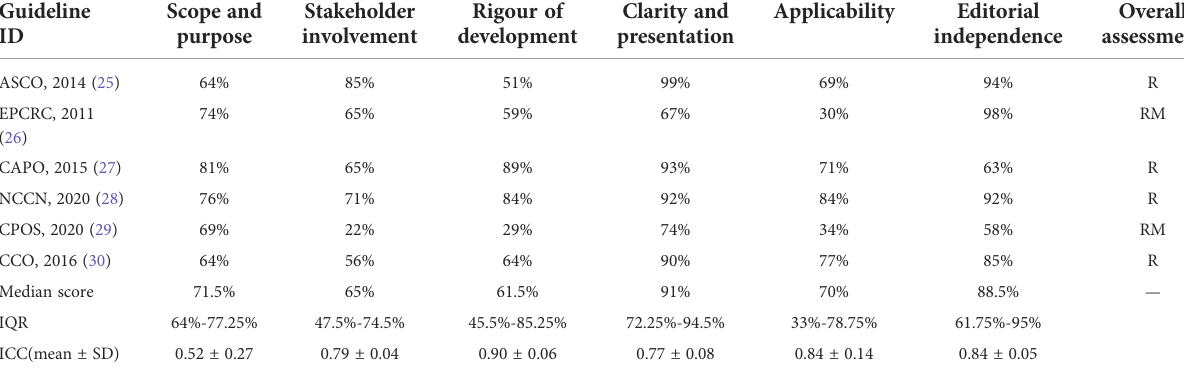
TABLE 3 AGREE II domain score of included